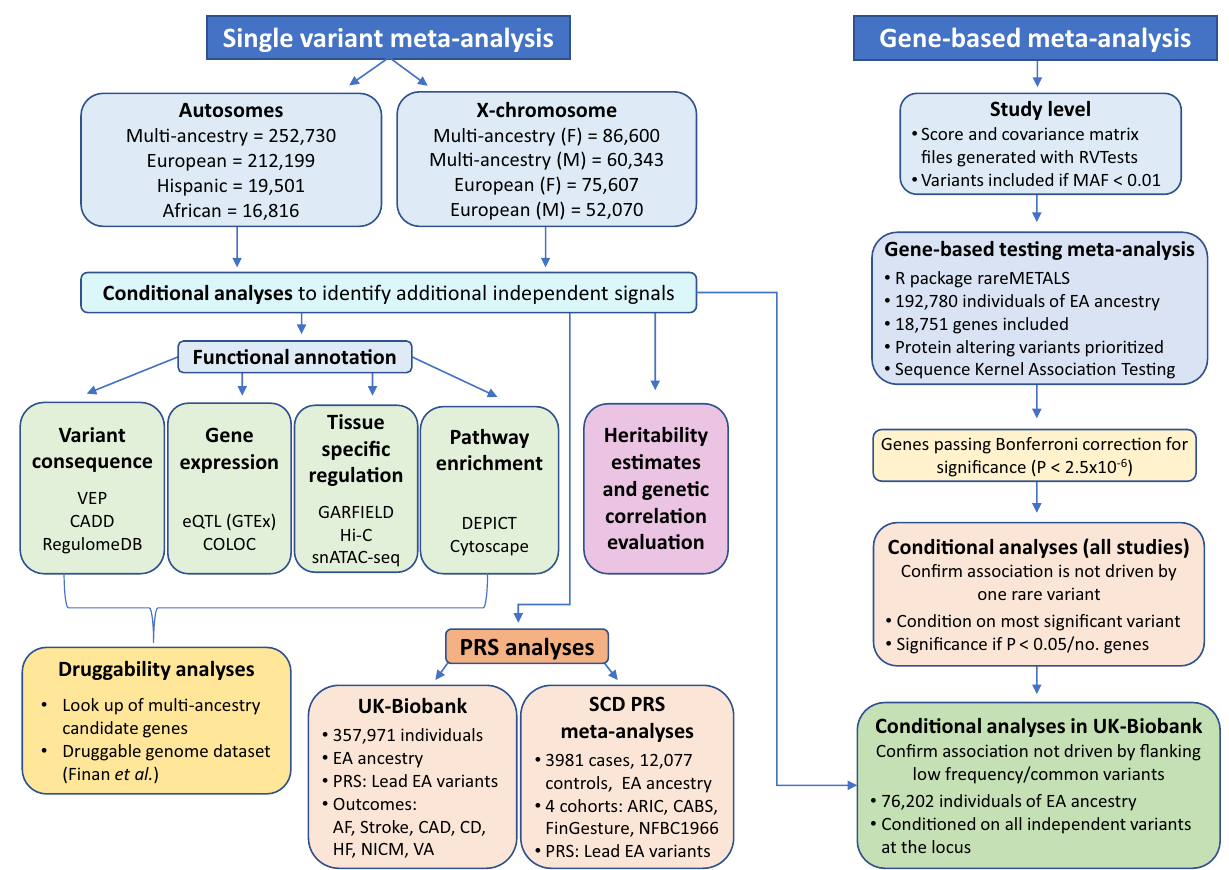
Fig. 2 | Work fl ow of the genetic analyses performed for QT, JT, and QRS. Work fl ow including single variant and gene-based meta-analyses, and down- stream bioinformatics. VEP (Variant Effect Predictor), CADD (Combined AnnotationDependentDepletion),eQTL(expressionQuantitativeTraitLocus), GTEx (Genotype-Tissue Expression project), COLOC (Colocalization), GAR- FIELD (GWAS Analysis of Regulatory and Functional Information Enrichment